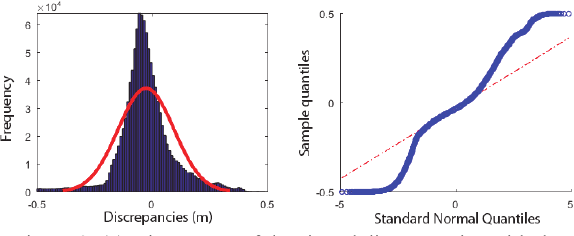
Figure 8. (a) Histograms of the signed discrepancies with the superimposed curve for the normal distribution and (b) Q-Q plot of the distribution of the signed discrepancies